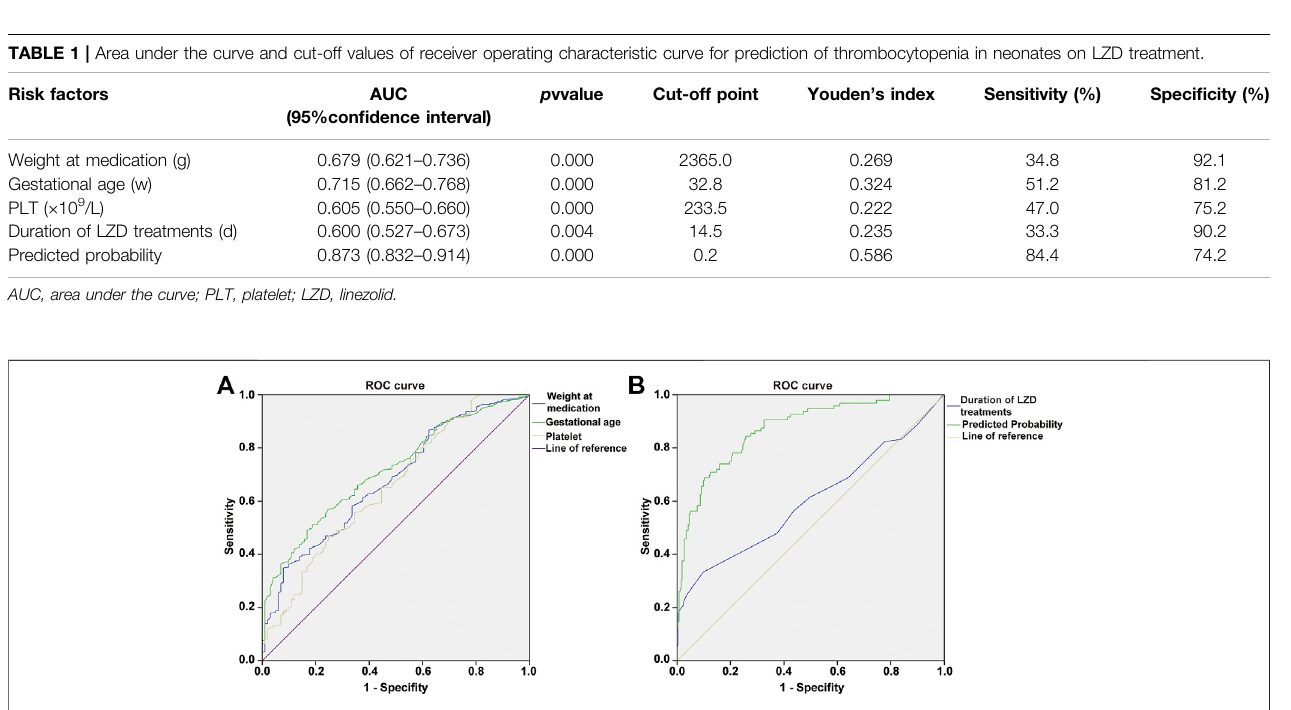
FIGURE 5 | ROC curve of weight at medication, gestational age, platelet (A) ; duration of LZD treatments, predicted probability (B) , independent risk factors and combinedpredictorforLIT.Thepredictedprobabilityofcombinedmedicationweight(AUC=0.679),gestationalage(AUC=0.715),platelet(AUC=0.605),andduration of LZD treatments (AUC = 0.600) had better sensitivity (84.4%) and speci fi city (74.2%), Youden ’ s index 0.586, as well as the maximal AUC (AUC = 0.873).